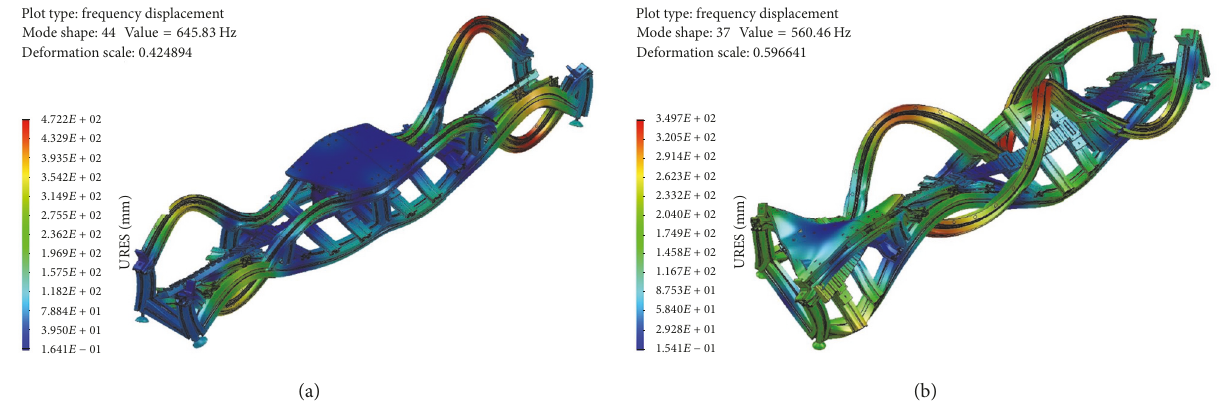
Figure 20: Modes with complex displacement function: (a) mode 44 at position P3 ( 𝑓 ≈ 646Hz, def. scale ≈ 0.425), multipart transversal displacements (along YY ); (b) mode 37 for position P5 ( 𝑓 ≈ 560 Hz, def. scale ≈ 0.597), transverse displacements in bars and torsion on bars and plates.